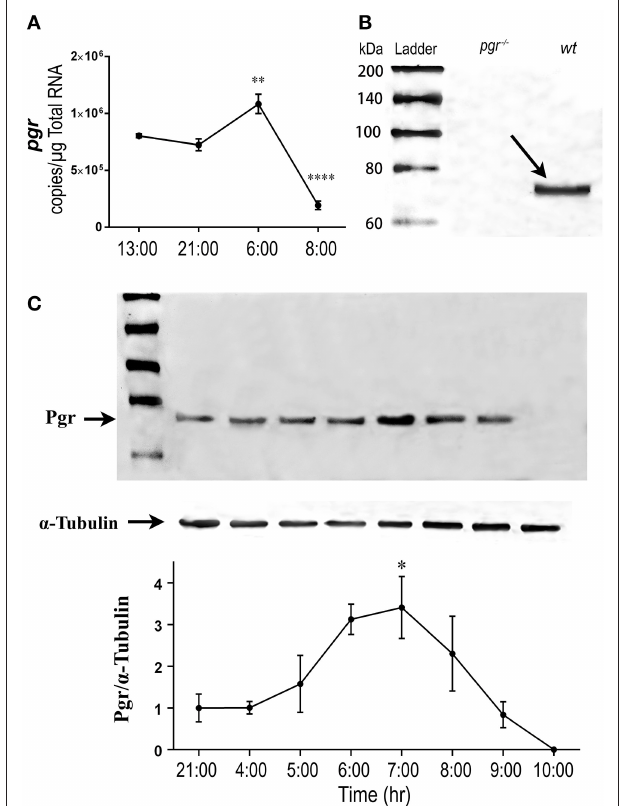
FIGURE 4 | Transient increase of nuclear progestin receptor (Pgr) in follicular cells prior to ovulation in vivo . (A) Changes of pgr transcript. Transcripts were determined by quantitative real-time PCR (qPCR) in the follicular cells of stage IV follicles in an ovulatory cycle in wildtype ( wt ) zebrafish. Asterisks indicate significant change of transcripts compared to the previous time point. ** p < 0.01, **** p < 0.0001. N = 5. (B) Western analysis of Pgr protein expression in stage IV follicles in pgr − / − or wt . Arrow indicates the specific band of zebrafish Pgr at the approximate size of 69 kDa in wt fish. No band was observed in pgr − / − . (C) (Top) Representative images of a Western blot of Pgr proteins from stage IV (IVa or IVb) follicles sampled at various time of a spawning cycle. α -tubulin was used as an internal control for normalization of expression of Pgr protein; (Bottom) normalized Pgr expression at various time compared to Pgr expression at 21:00. Asterisks indicate significant difference compared to the value at 21:00. Experiment was repeated three times with results of one representative experiment presented as mean ± SEM. * p < 0.05. N =